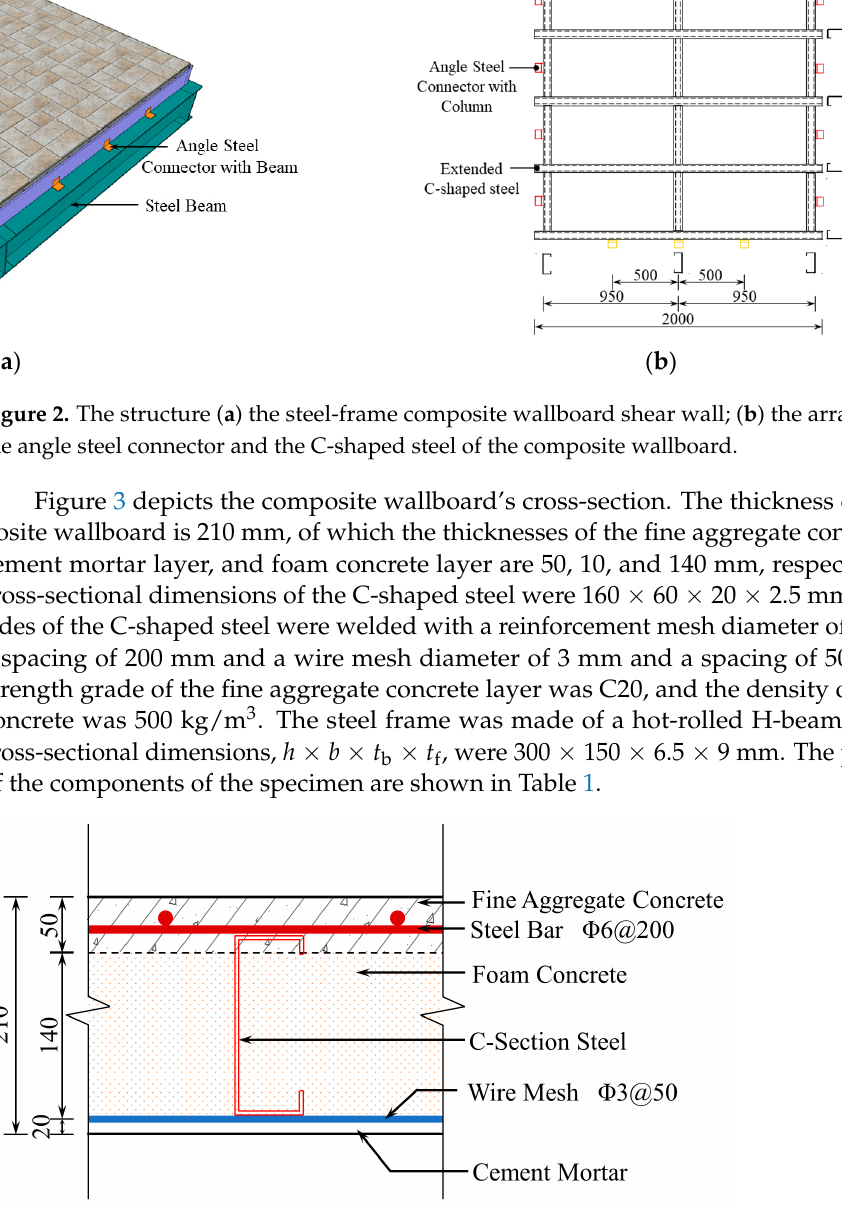
Figure 3. Cross-section of the composite wallboard. Table 1. Parameters of the component.